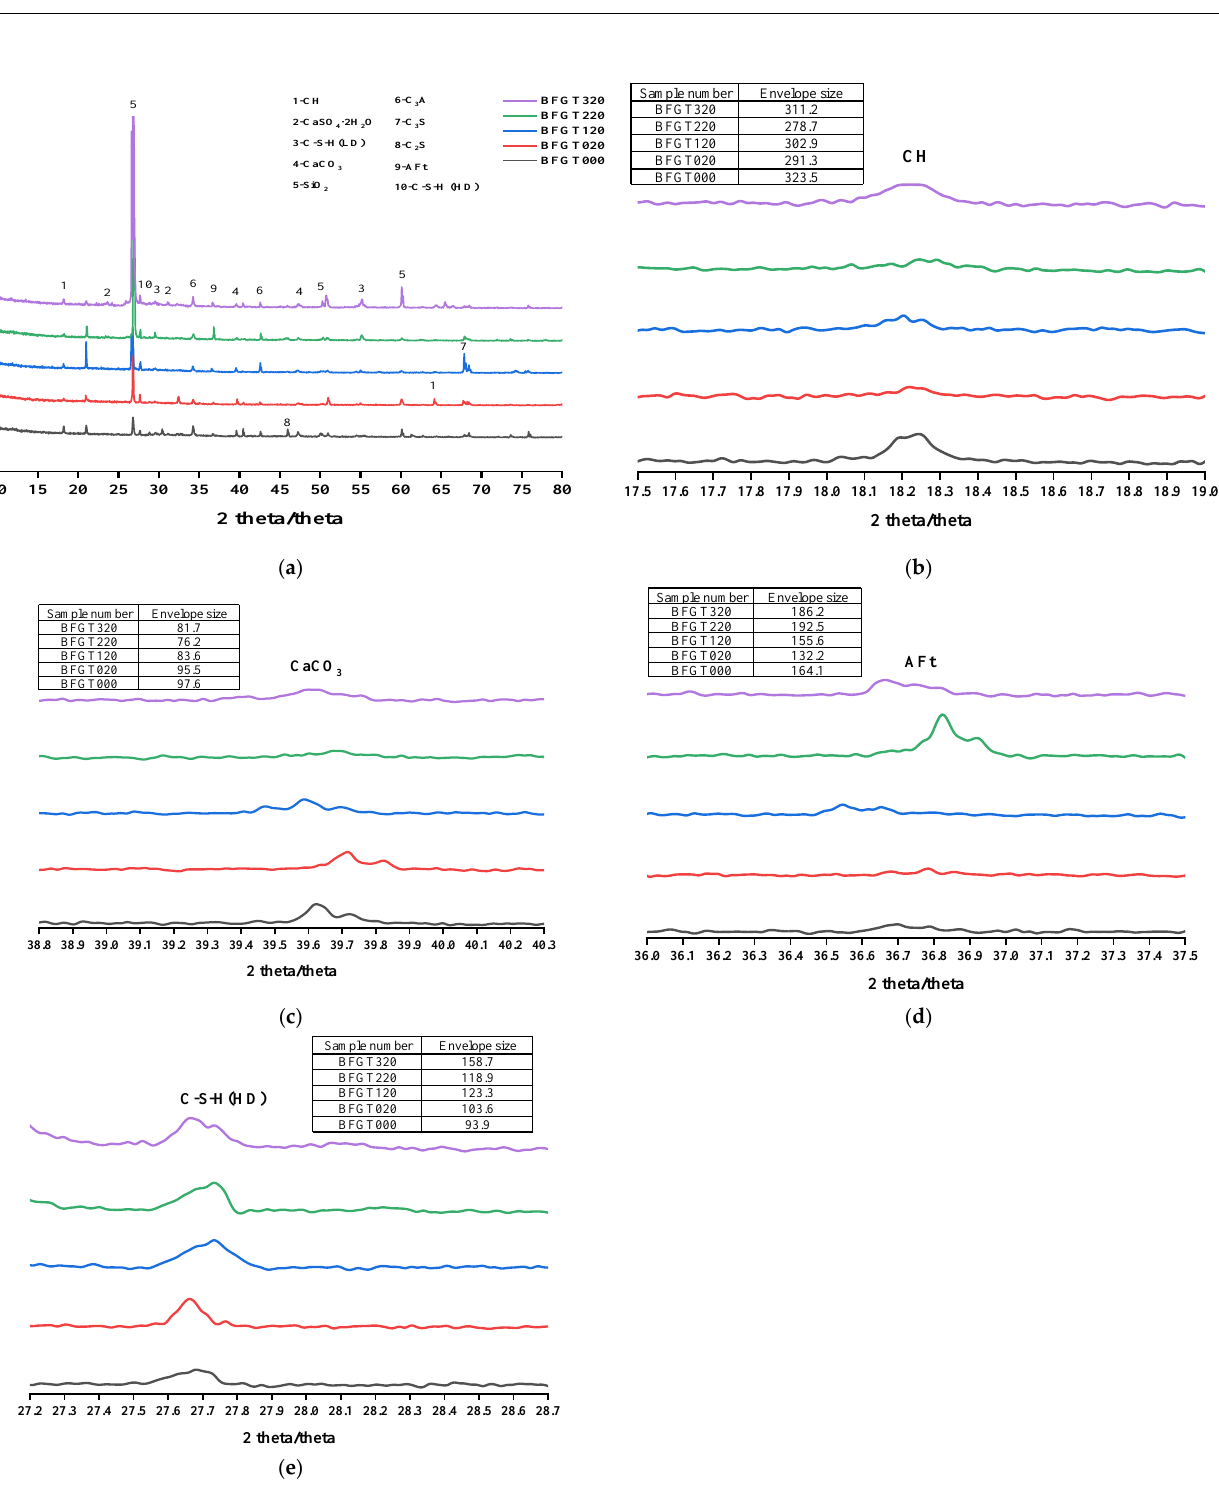
Figure 12. Hydration product analysis of BFR-GTCM for 28 days: ( a ) XRD diffraction pattern; ( b ) partial enlargement of the hydration product CH; ( c ) partial enlargement of the hydration product CaCO 3 ; ( d ) partial enlargement of the hydration product AFt; ( e ) partial enlargement of the hydration product C-S-H.